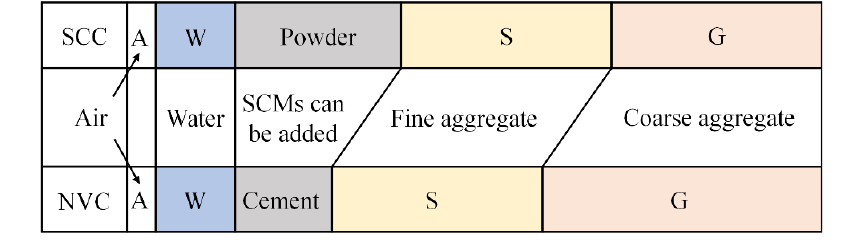
Figure 1. Comparison of component proportions between SCC and NVC [1].